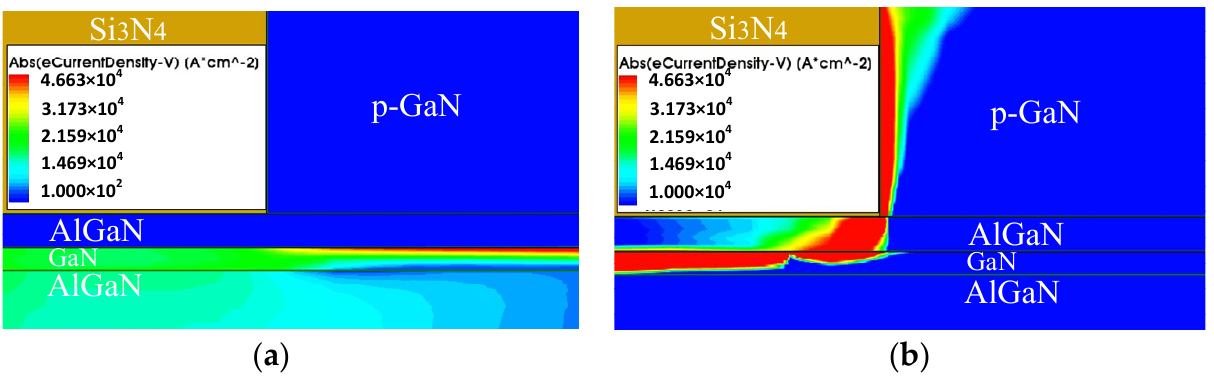
Figure 13. ( a ) Electron current distribution near the source before breakdown; ( b ) electron current distribution near the source after breakdown.